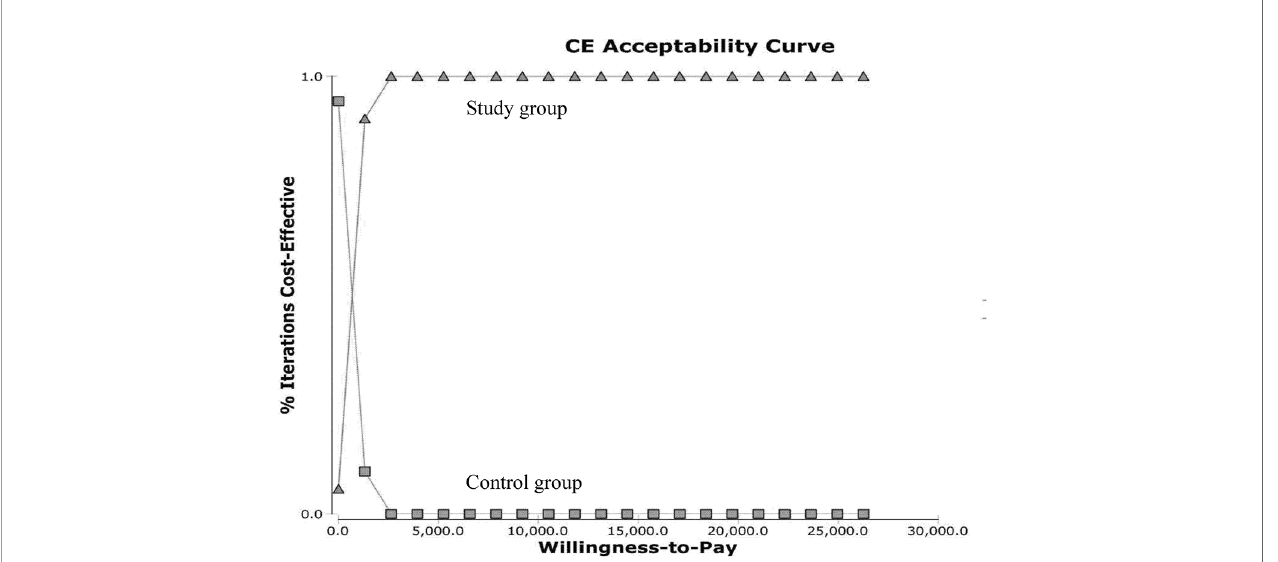
FIGURE 5 | Cost-effectiveness acceptability curves for the probabilistic sensitivity analysis. Results from 1,000 resamplings in the probabilistic sensitivity analysis created synthetic populations of patients from the trial using bootstrapping. The lines represent the fraction of simulation iterations in which the study group achieved more cost-effectiveness than the control group (y-axis) at various levels of willingness to pay for quality-adjusted life-year (QALYs) gains